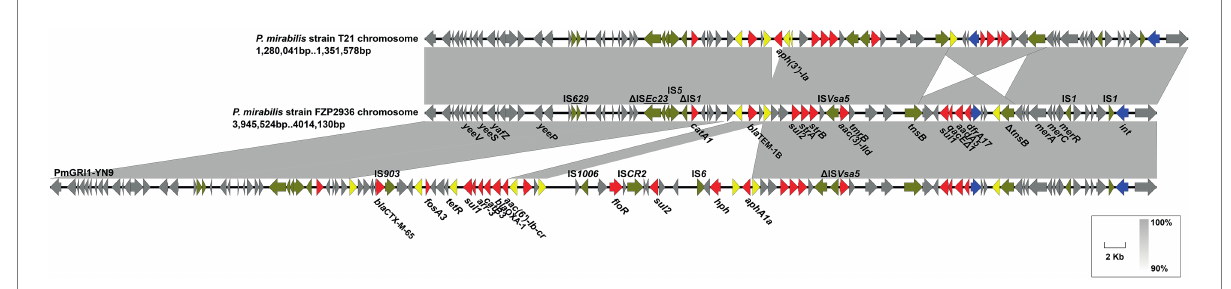
FIGURE 6 Genetic features of the multidrug-resistant genomic island in FZP2936. The genomic island in FZP2936 is compared with PmGRI1-YN9 and related region in Proteus mirabilis strain T21. Genes are denoted by arrows, and ARGs, integrase genes, IS 26 , and other transposase genes are highlighted in red, blue, yellow, and olive, respectively. Regions of > 90% identity are indicated by grey shading. Δ represents truncated